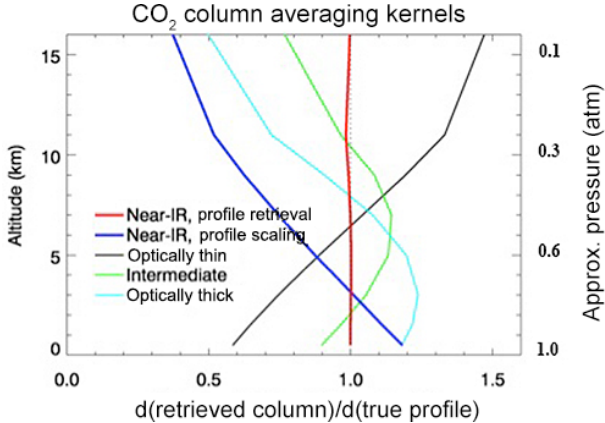
Figure 2. Partial column averaging kernels for the profile retrieval algorithm of Fig. 1 (GFIT2 applied to the 6220cm − 1 spectral band, with assumed signal-to-noise ratio =